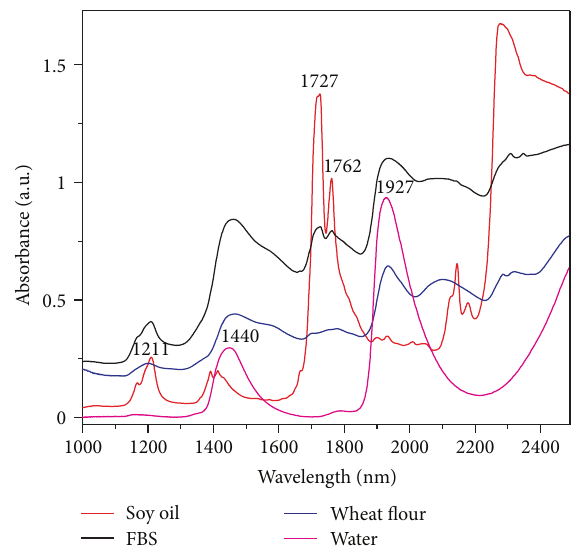
Figure 3: FT-NIR spectra of FBS and their main ingredients including wheat flour, water, and soy